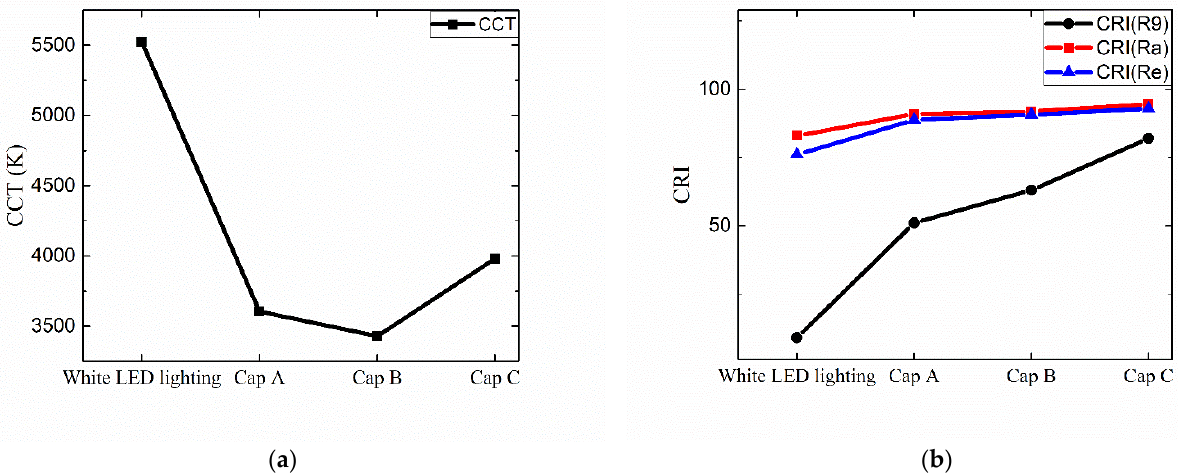
Figure 10. The dependence of ( a ) the CCT and ( b ) the three CRI values (Ra, Re, R9) on the optical configuration of the lighting.